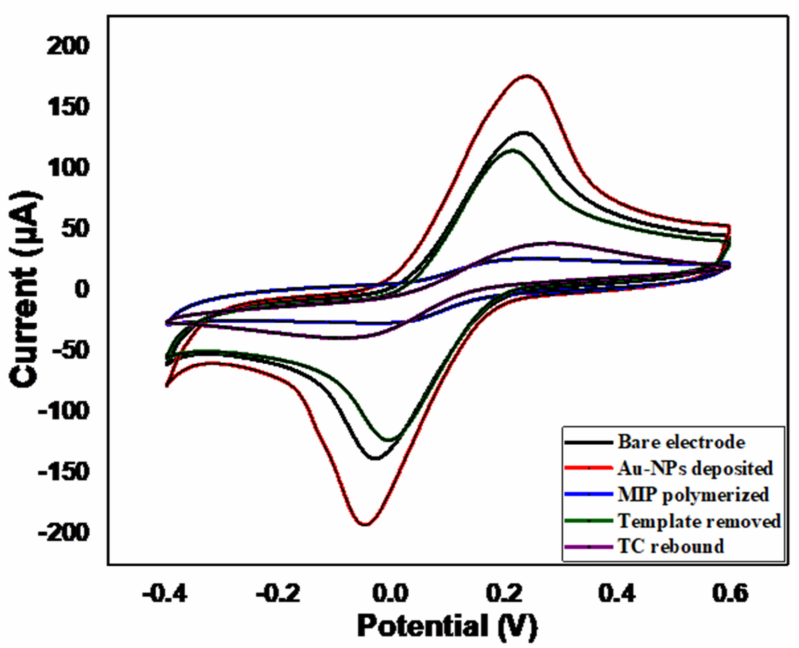
Figure 5. Cyclic voltammetry curves obtained after each modification step of LIG